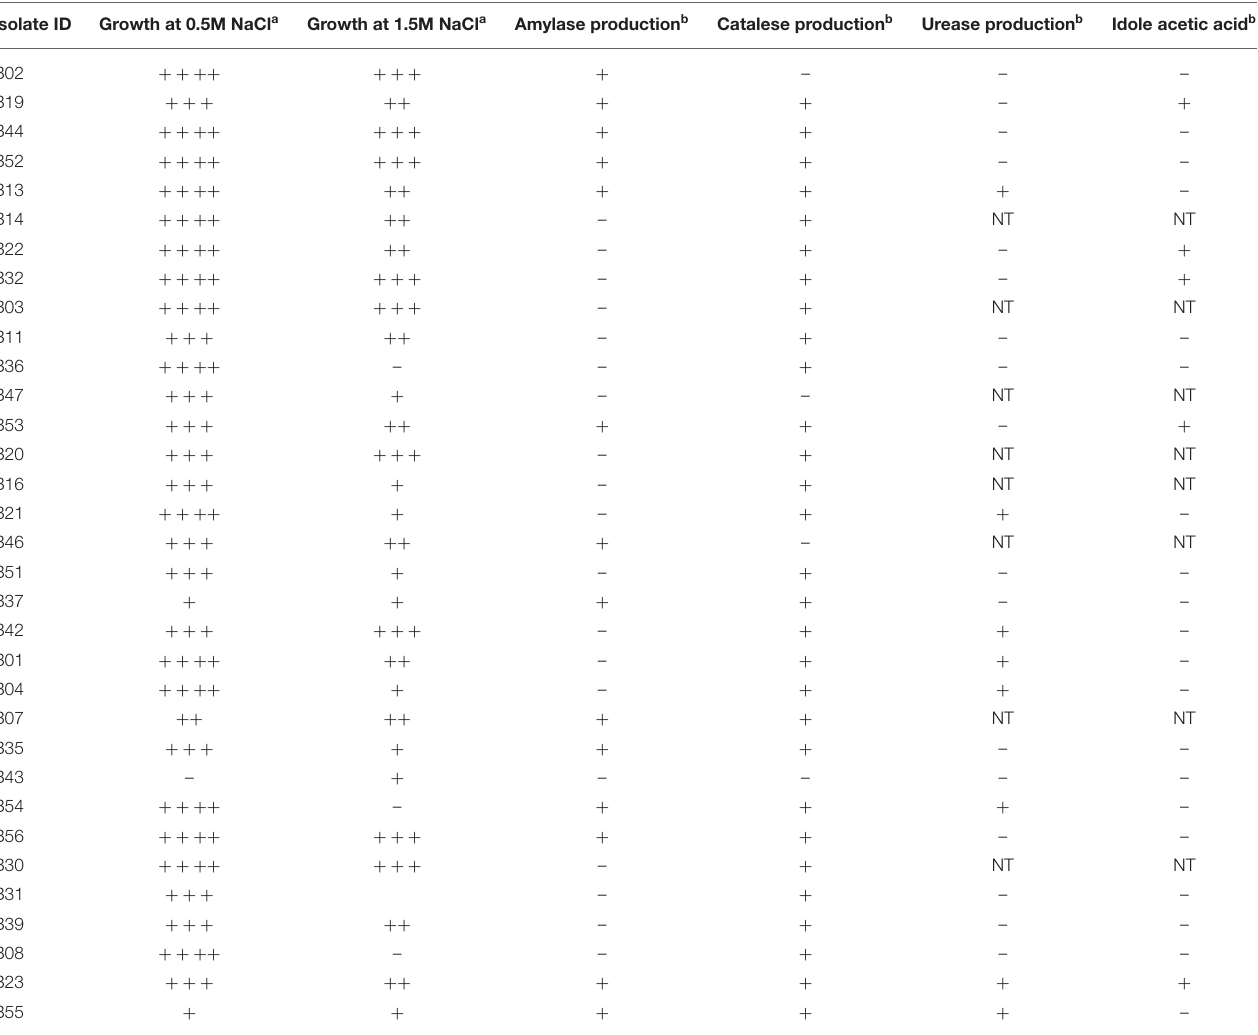
TABLE 1 | Characterization of endophytic bacterial